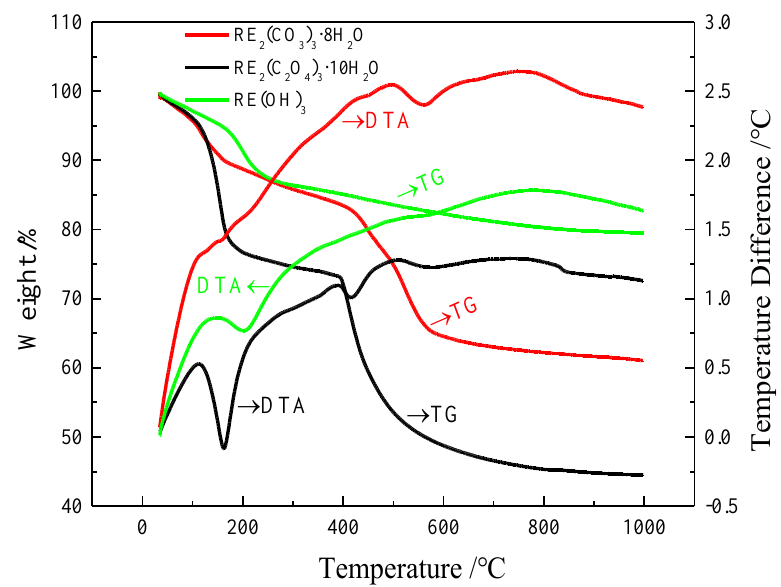
Figure 13. TG–DTA curves of RE 2 (CO 3 ) 3 · 8H 2 O, RE 2 (C 2 O 4 ) 3 · 10H 2 O, and RE(OH) 3 . The RE x O y obtained from the calcination of RE 2 (CO 3 ) 3 · 8H 2 O and RE 2 (C 2 O 4 ) 3 · 10H 2 O at 850 ◦ C and the calcination of RE(OH) 3 at 700 ◦ C were analyzed via XRD to confirm the main mineral phase composition. The results shown in Figure 14 indicate that the roasting products of the three REE precipitates are all composed of Pr 6 O 11 , Ce 6 Nd 2 O 15 , and (Ce 0.7 Gd 0.3 )O 1.85 . The SEM analysis of the roasted products (Figure 15a) showed that the REEs obtained from the calcination of RE 2 (C 2 O 4 ) 3 · 10H 2 O were found to be irregularly cubic in shape, ranging in size from 2–5 µ m. Moreover, the EDS results (Figure 15b) of RE x O y indicated that the main components of the products are REEs, and no other metal impurities were detected. The structure of the RE x O y obtained via the calcination of RE 2 (CO 3 ) 3 · 8H 2 O is a polyhedron with a random shape and a size range of 0.5–2 µ m (Figure 15c). However, the calcination products of RE 2 (CO 3 ) 3 ·8H 2 O contain a small amount of S in addition to REEs (Figure 15d). The structure of the RE x O y obtained by the calcination of the RE(OH) 3 is mostly irregular cone in terms of shape and ranges in size from 1–4 μm (Figure 15e). The EDS results (Figure 15f) showed that the calcination products contain a small amount of Si. To compare the purity of these calcined RE x O y products, the main chemical composition of the above three products of RE x O y were further analyzed in de- tail, and the results are shown in Table 2.